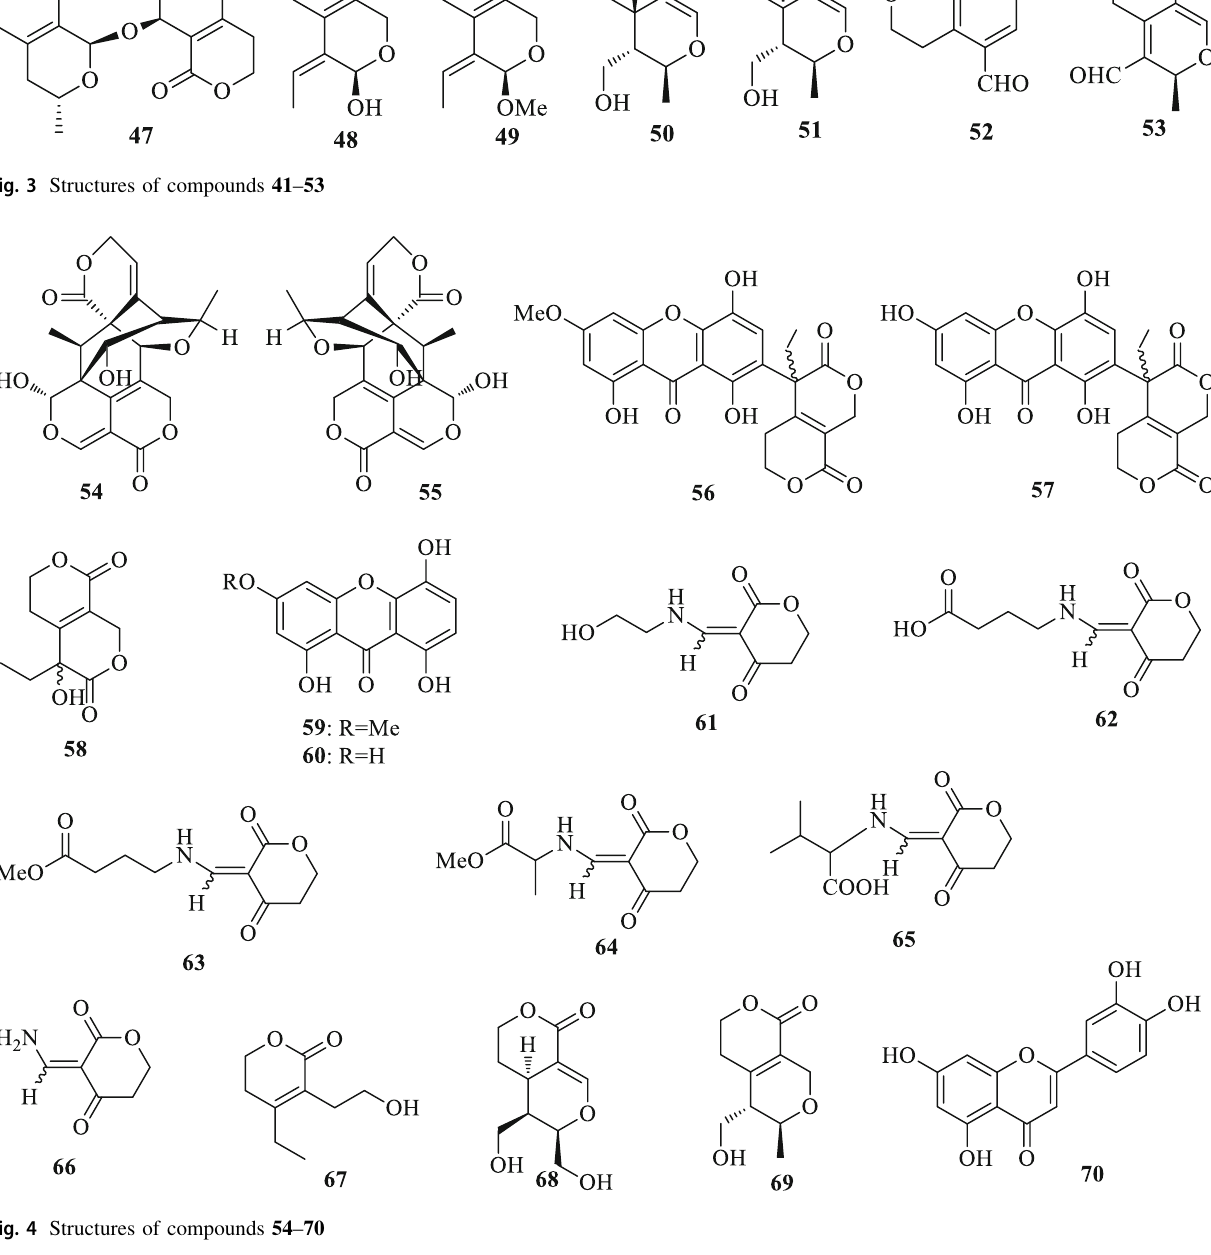
Fig. 4 Structures of compounds 54 –